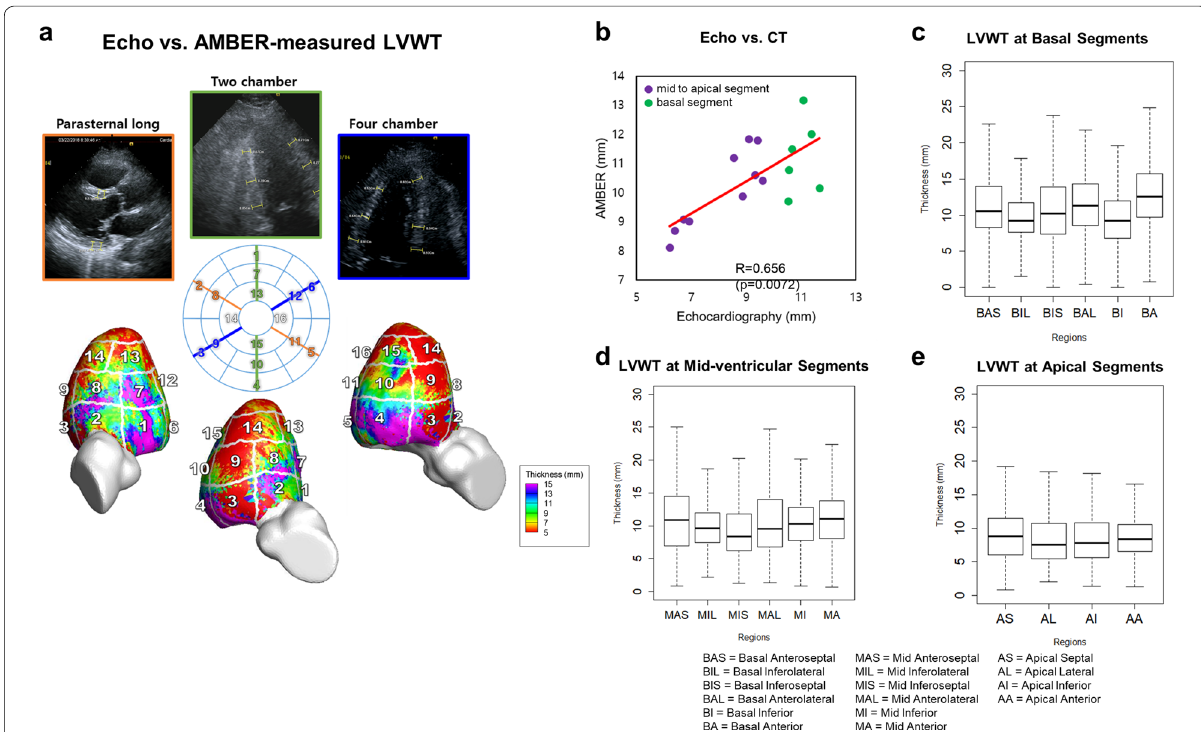
Fig. 5 The comparison results of LVWT measured by echocardiography and AMBER in 10 patients. a The echocardiography and LVWT were evaluated by splitting into a 16‑segment model of the left ventricle (without apical cap). b LVWT positively correlated with echocardiography, and the lines represent the linear regression analysis. c – e Box plot evaluated divided into Basal, Mid‑ventricular, and Apical